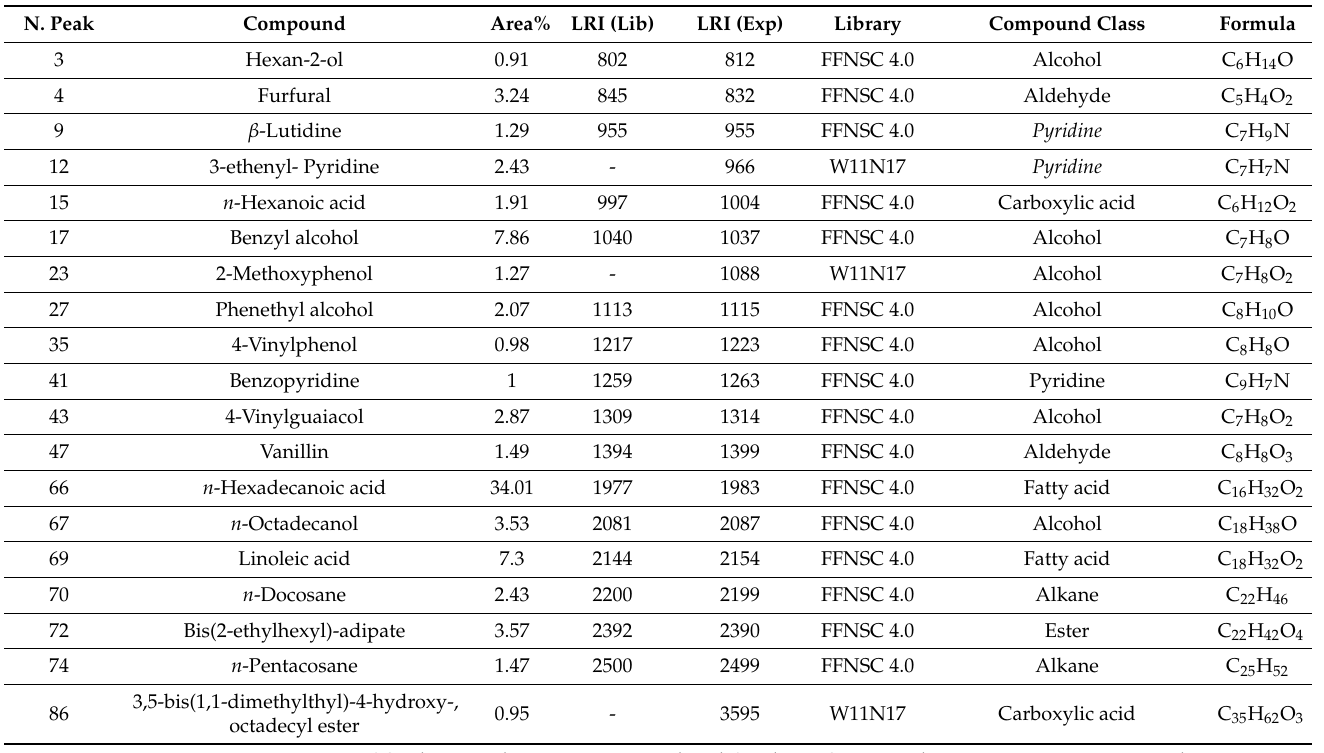
FFNSC: Flavor and Fragrance Natural and Synthetic Compounds; LRI: Linear Retention Indices; W11N17: Wiley11-Nist17.